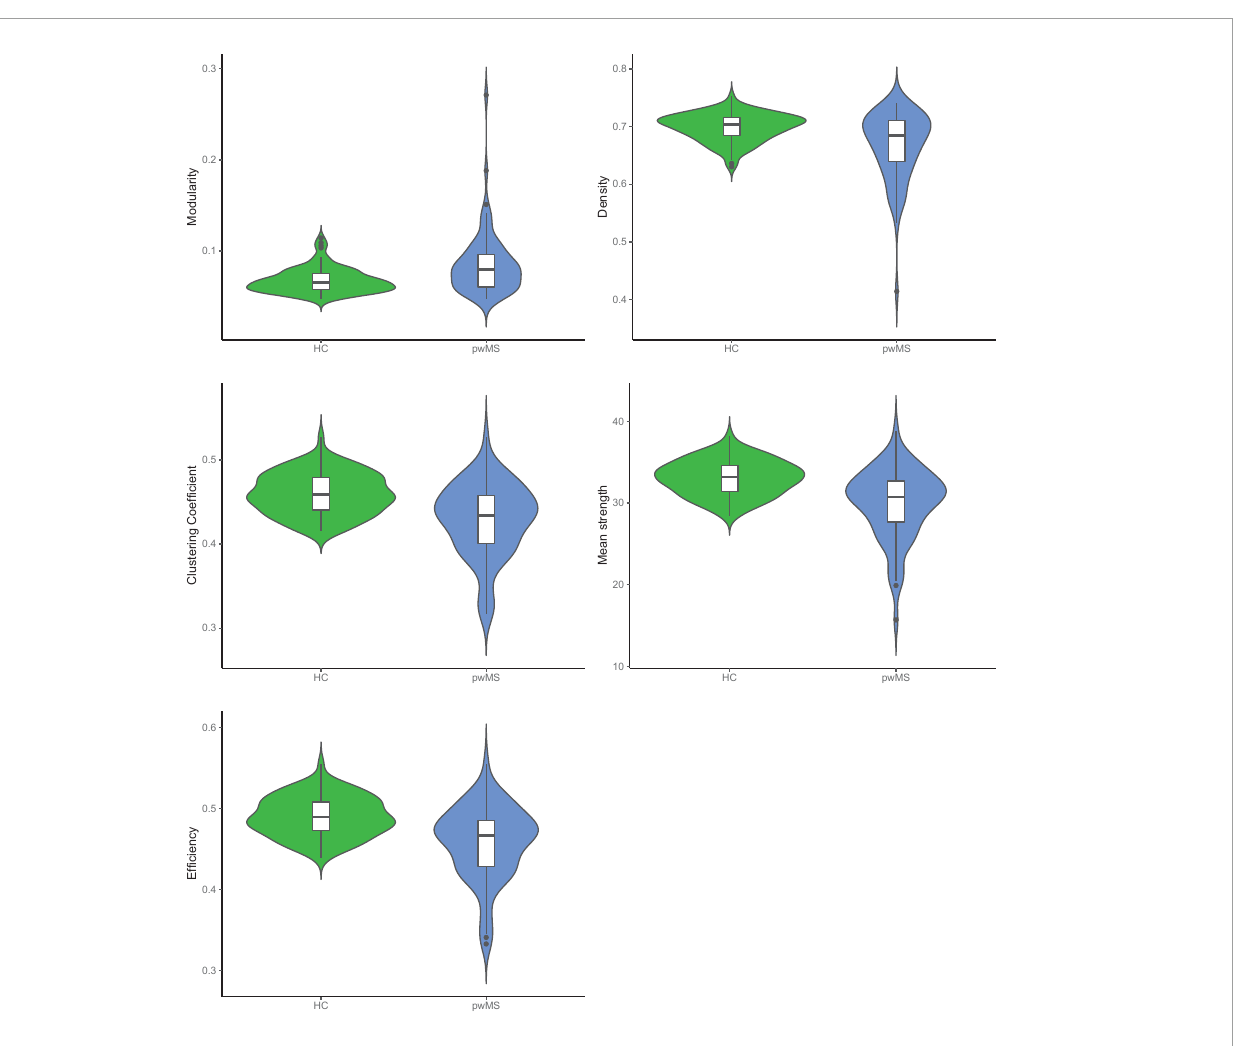
FIGURE2 Violin plots of the five global network metrics for healthy controls (HC) and patients with multiple sclerosis (pwMS). The figure shows violin plots between the two groups and the five global network metrics. Bars in the middle represent median values. The whiskers show 95% confidence interval, and the shape of each violin plot displays the frequencies of values, here: number of participants with same global network